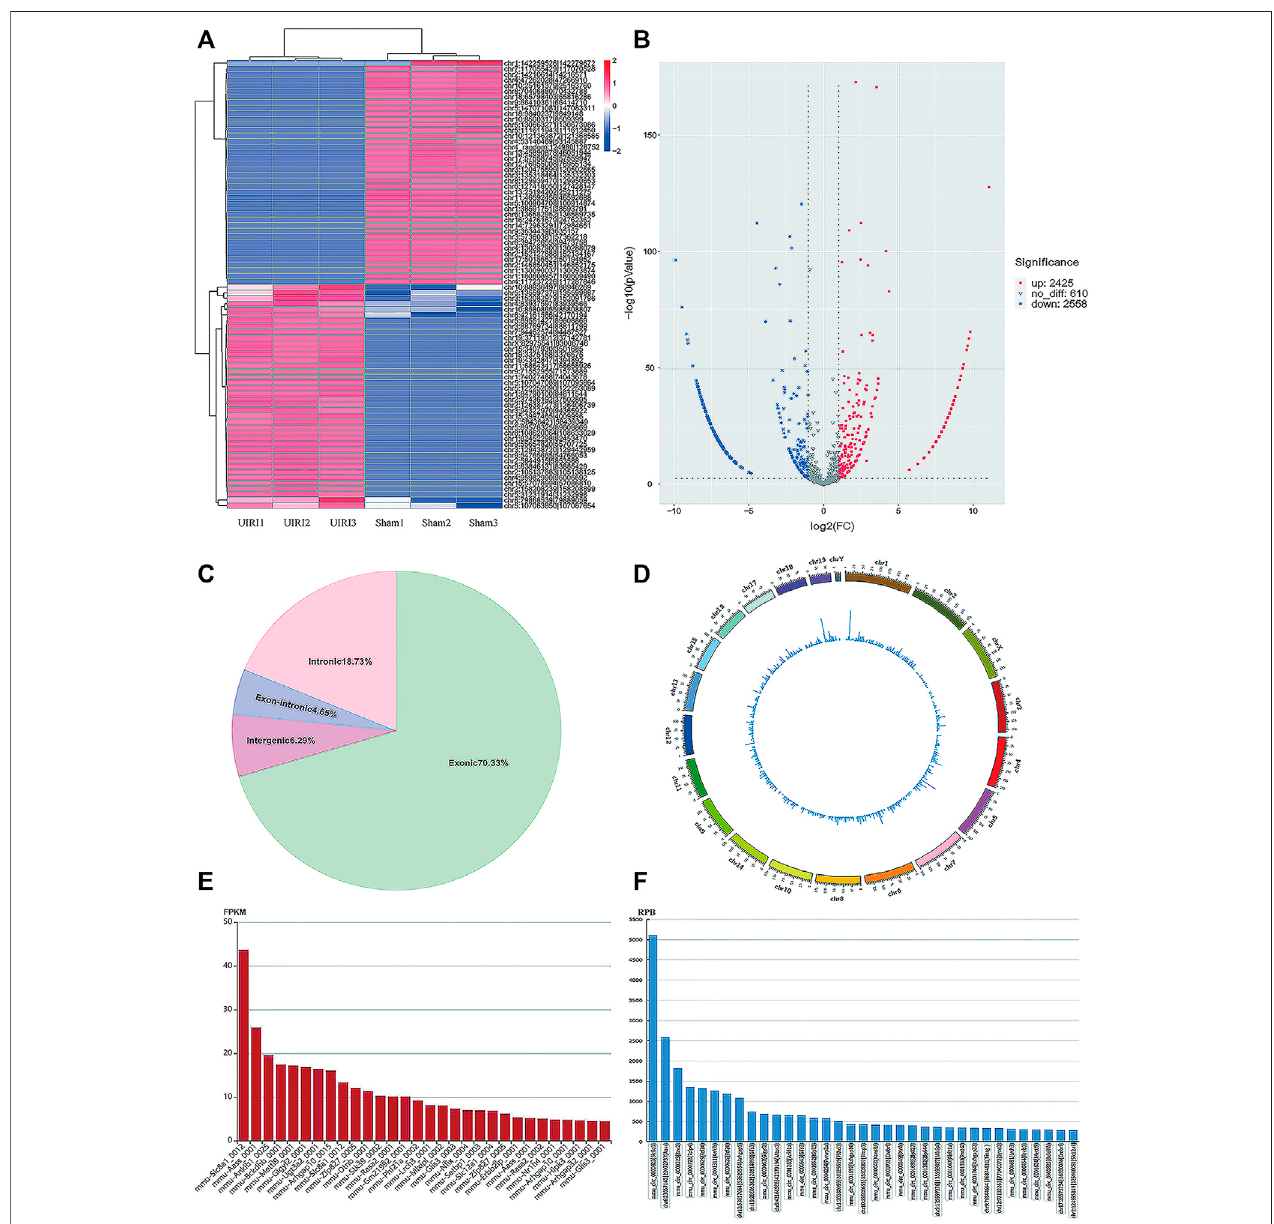
FIGURE 2 | CircRNA expression pro fi les of the UIRI group. (A) The heatmap of representative differentially expressed (DE) circRNAs. (B) Volcano plot showing signi fi cantly DE circRNAs. Red and blue pixels represent upregulated and downregulated genes, respectively, while gray pixels indicate genes with no signi fi cant difference. An absolute value of fold-change > 2.0 and p < 0.05 were considered as signi fi cantly different. (C) The subtypes of the DE circRNAs. (D) Circos plot of DE circRNAsillustrating theirdistribution onthechromosome. (E) Thetop30mostabundantcircRNAsinmousekidneysfromthecircAtlasdatabase. (F) The35most enriched circRNAs in our sequencing data for normal mouse kidneys. ** p < 0.01 vs. sham group.